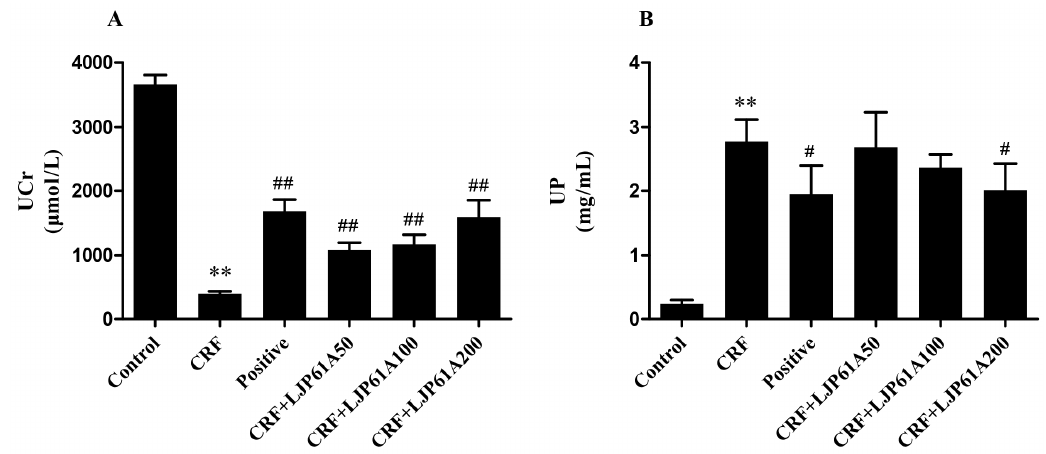
Figure 5. The effects of LJP61A on the UCr ( A ) and UP ( B ) levels of adenine-induced CRF mice. ** p < 0.01 (vs. Control group); # p < 0.05, ## p < 0.01 (vs. CRF group).